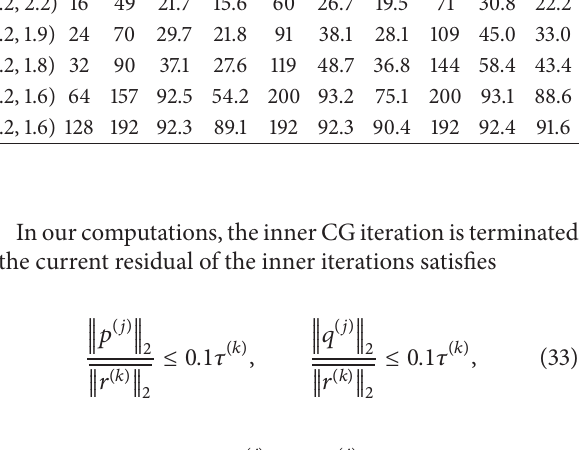
Table 7: Convergence results for IGPMHSS with 𝑃 1 = 𝑃 2 = 𝑇 . 𝜏 = (𝛼 ,𝛽 ) 𝑚 𝐺 𝐺